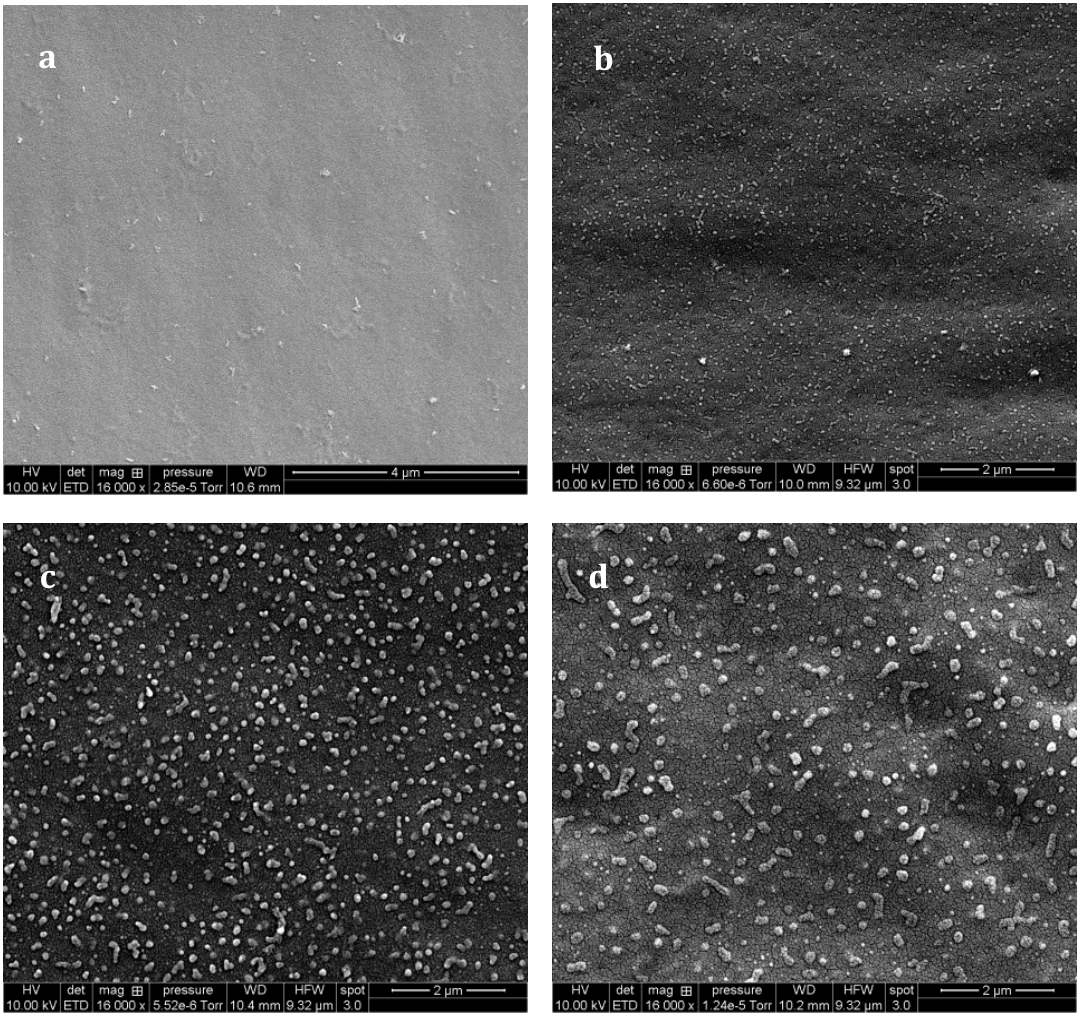
Figure 8. SEM observations (after chemical treatment) of the f-PES modified system as a function of T cure : 90 °C ( a ); 130 °C ( b ); 150 °C ( c ) and 180 °C ( d ).